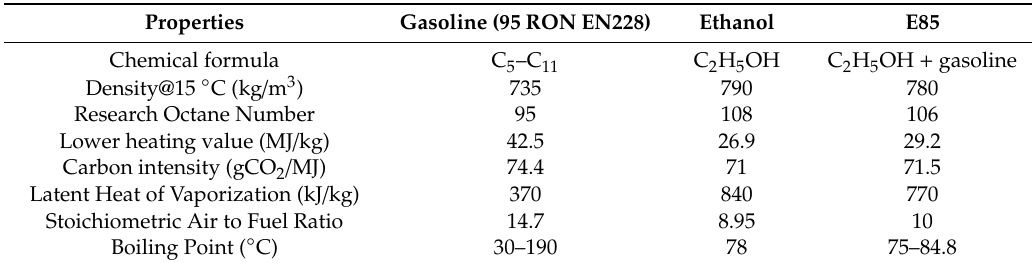
Table 2. Test fuel